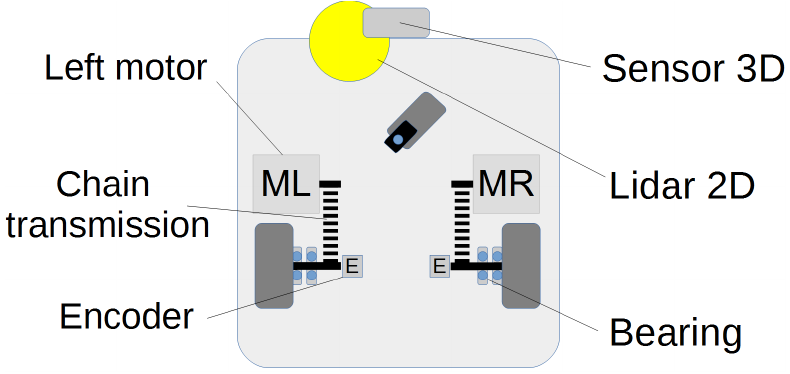
Figure 5. Placement of relevant robot